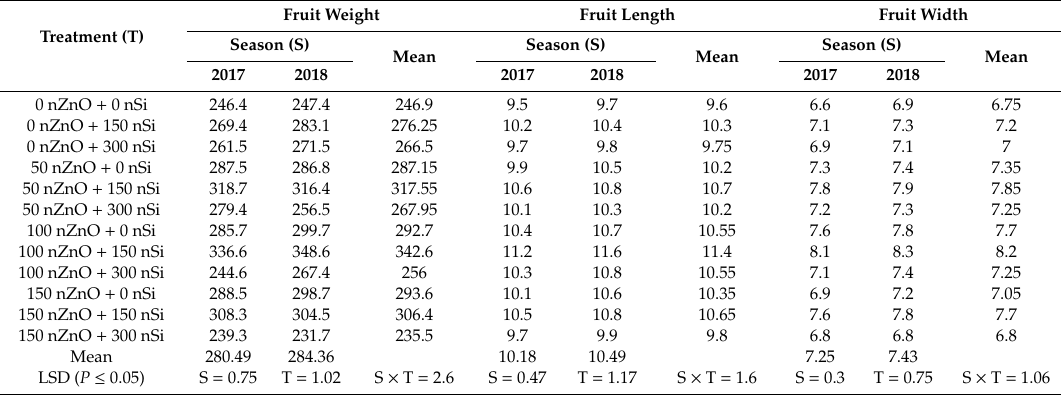
Table 7. E ff ect of foliar spray with ZnO and Si NPs (mg / L) on the average fruit weight (g), length, and width (cm) of “Ewais” mango trees during the 2017 and 2018 seasons.